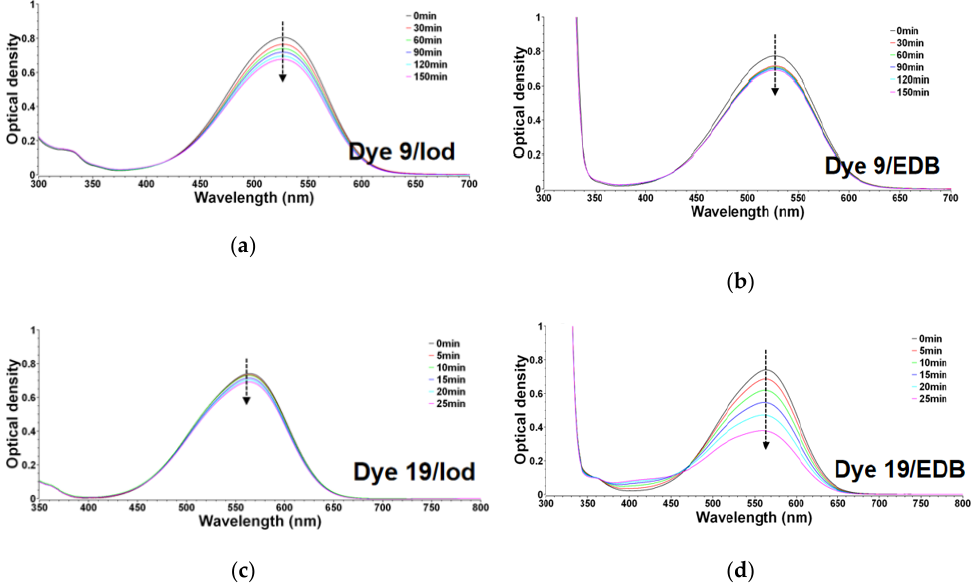
Figure 5. UV-visible absorption spectra of dyes 9 , 19 (1.30 × 10 − 5 M; 1.11 × 10 − 5 M, respectively.) (left) in the presence of iodonium salt (Speedcure 938, 1.46 × 10 − 4 M) upon exposure to LED@405nm under air in the solvent of acetonitrile: ( a ) dye 9 , ( c ) dye 19 and (right) in the presence of amine (Speedcure EDB, 4.07 × 10 − 4 M) upon exposure to LED@405nm under air in the solvent of acetonitrile: ( c ) dye 9 , ( d )